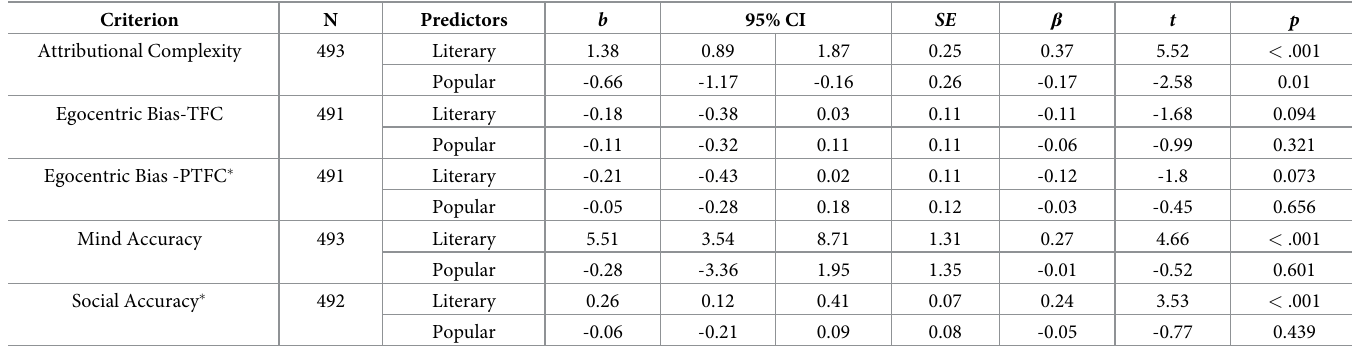
Table 1. Results of multiple regression conducted separately for each DV, using literary and popular ART scores as predictors, controlling for ART foils. Criterion N